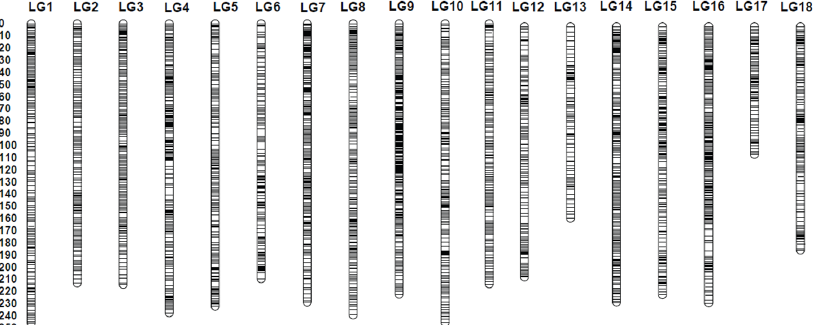
Figure 2. Positions at which markers were mapped on an 18-linkage-group integrated map con- structed from genotyping-by-sequencing data for 178 RRII 105 × F4542 progeny. The scale to the left of the map shows genetic distances in cM.